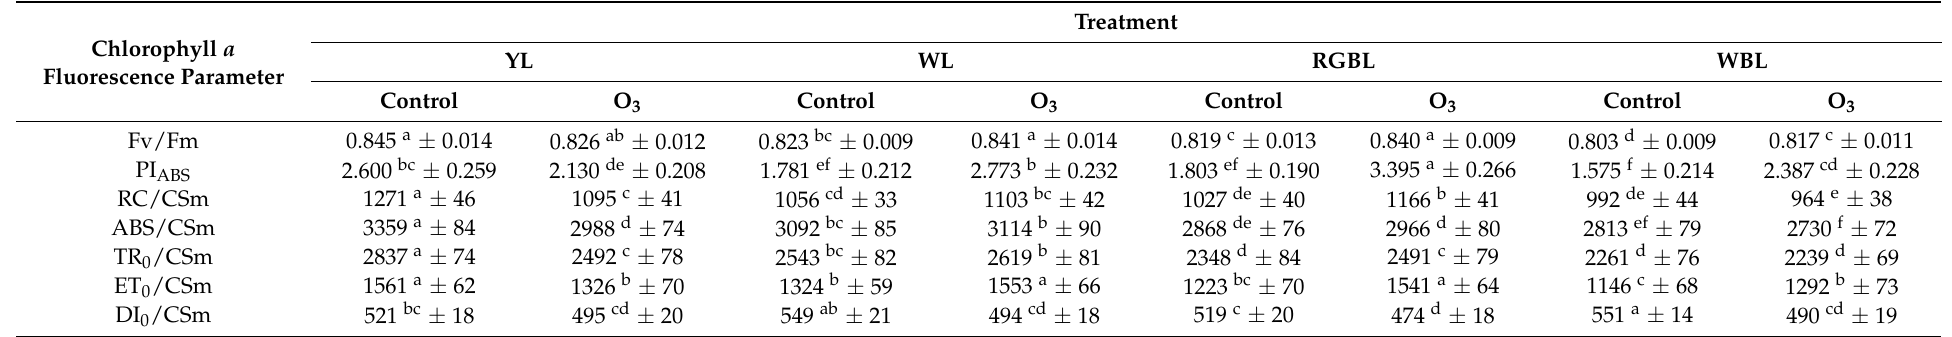
Table 1. Chlorophyll a fluorescence kinetics parameters of Brassica rapa subsp. pekinensis growing in a different light spectrum: YL—yellow light (sodium lamp), WL—white light (LED), RGBL—red + green + blue light (LED), WBL—white + blue light (LED), treated with ozone (100 ppb, 21 days) or not fumigated (control). Average values ( ± SD) marked with the same letters in a row do not differ significantly according to Duncan’s test, p ≤ 0,05, n = 7.